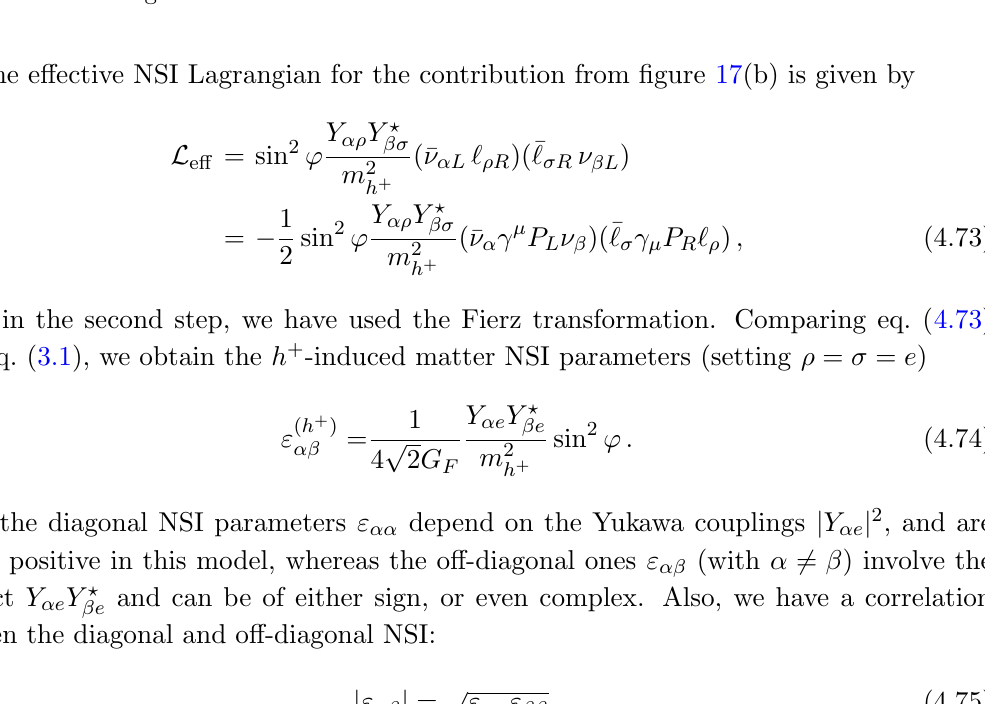
Figure 17 . Tree-level NSI induced by the exchange of charged scalars in the Zee model. Diagrams (a) and (d) are due to the pure singlet and doublet charged scalar components, while (b) and (c) are due to the mixing between